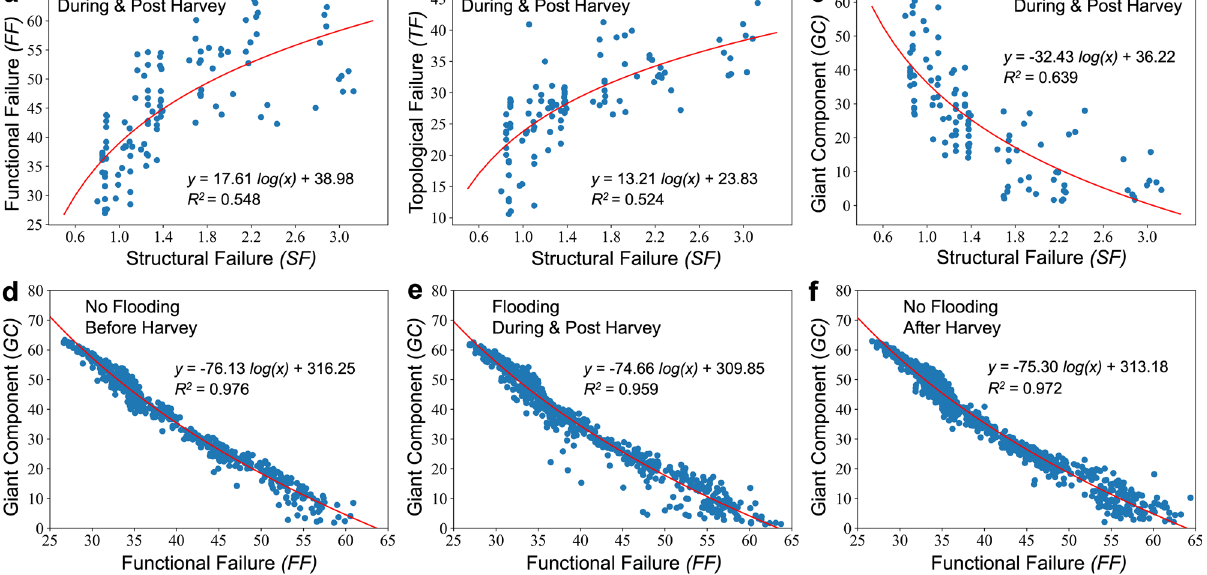
Fig. 6 Unveiling the relationship among structural failure (SF), functional failure (FF), topological failure (TF), and giant component (GC). We use q = 0.8 for the illustrative purpose. We use a y = a ~ log( x ) + b to fi t the empirical failure data. a , b , c Relationship between SF and FF, TF, and GC. Only non-negligible fl ooding (i.e., SF larger than 0.5%) during the time period 6:00 a.m. to 8:00 p.m. is considered. (See Supplementary Note 3 and Supplementary Fig. 5 for more details.) d – f Relationship between FF and GC in different stages of Hurricane